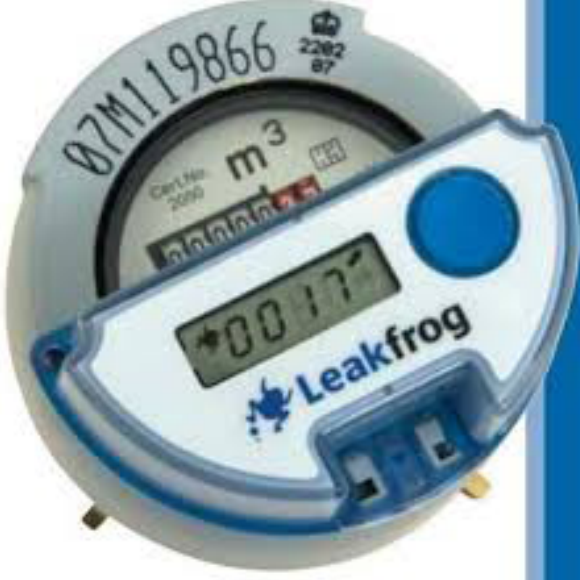
Figure 8: Leakfrog device installed on a water